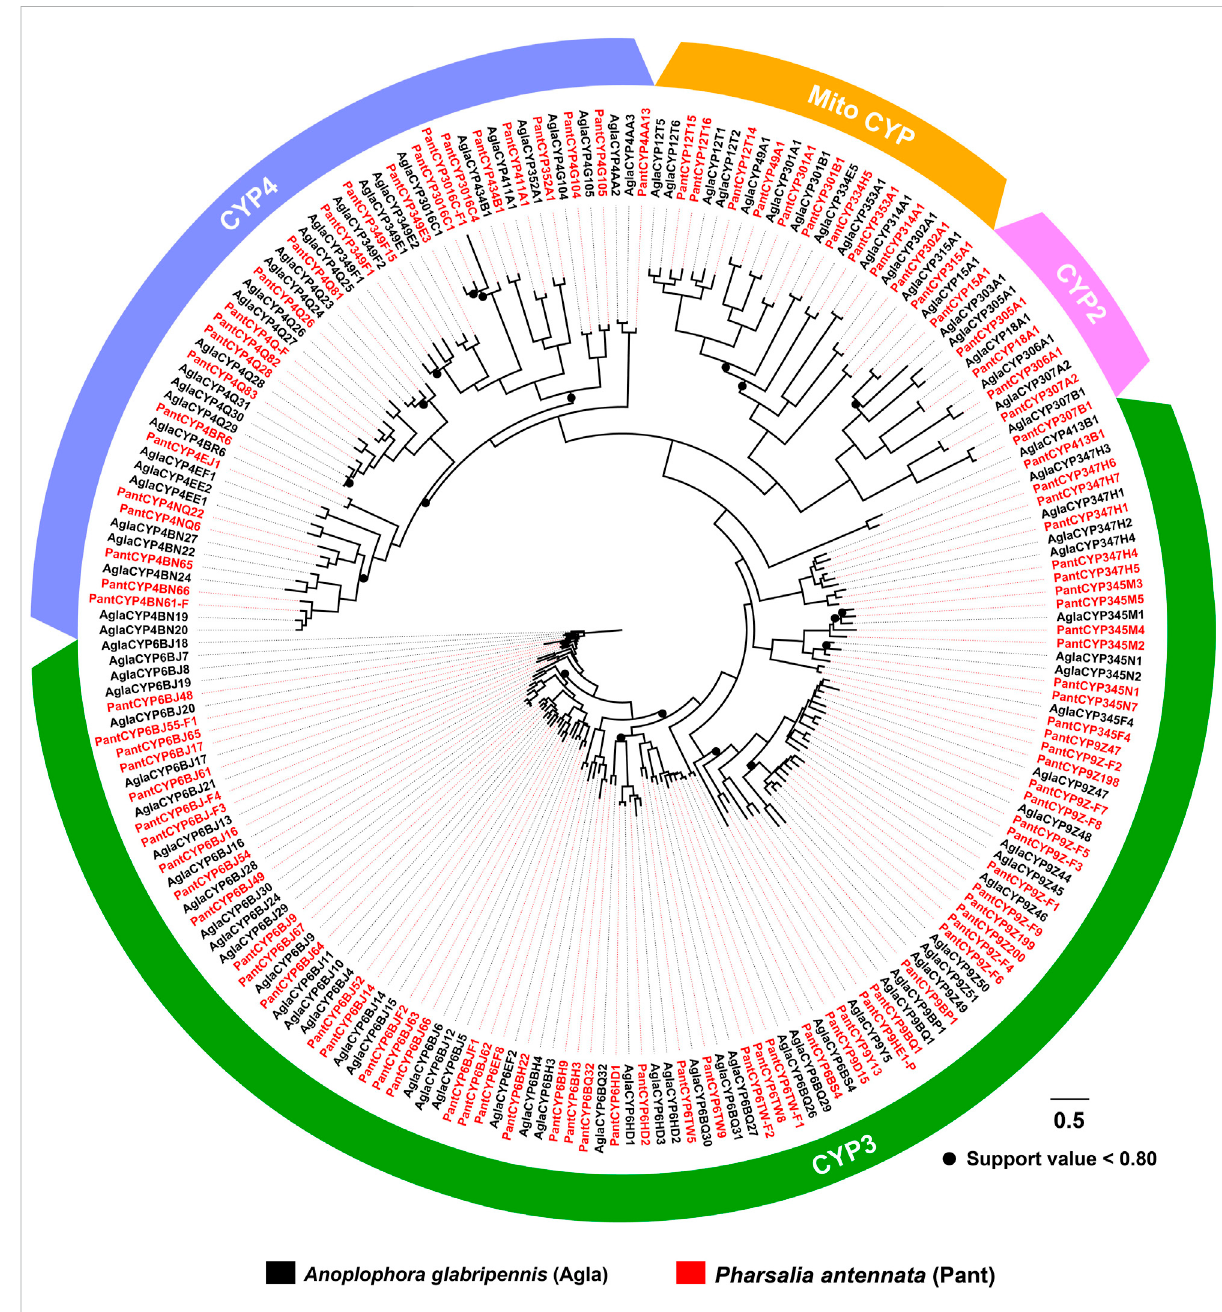
FIGURE 3 Maximum-likelihood tree of P450s in two cerambycid beetles. The P450 proteins in P. antennata are highlighted in red.